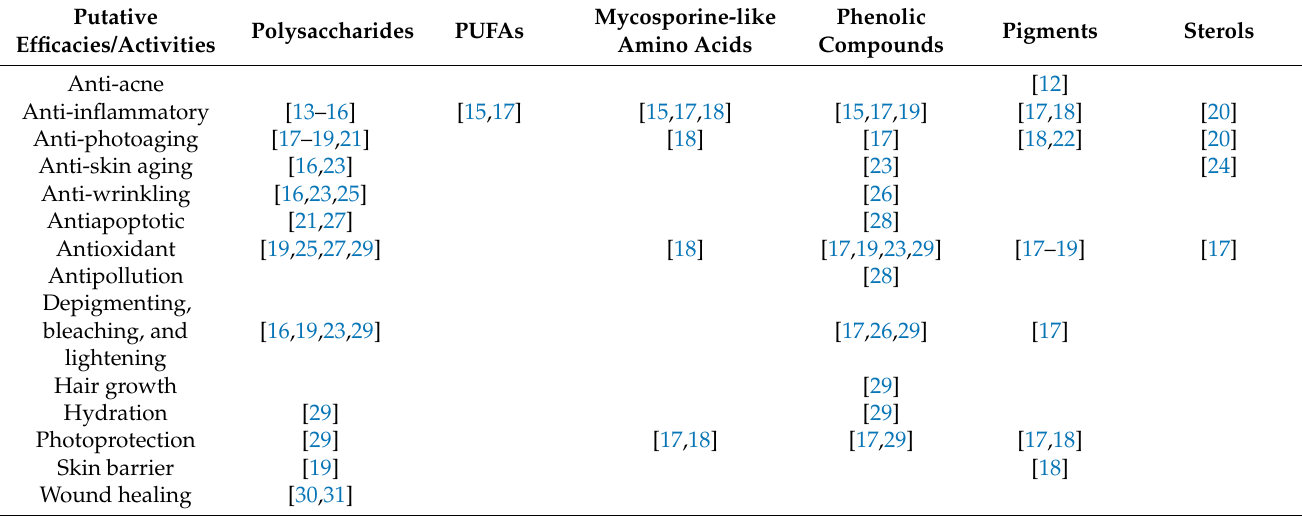
Table 1. Putative efficacy of some chemical classes from